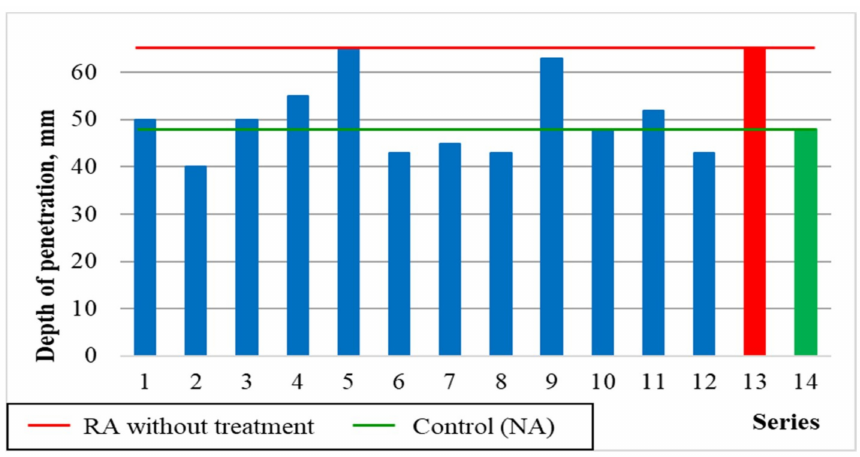
Figure 16. The water penetration of concretes compared with series 13 and 14.